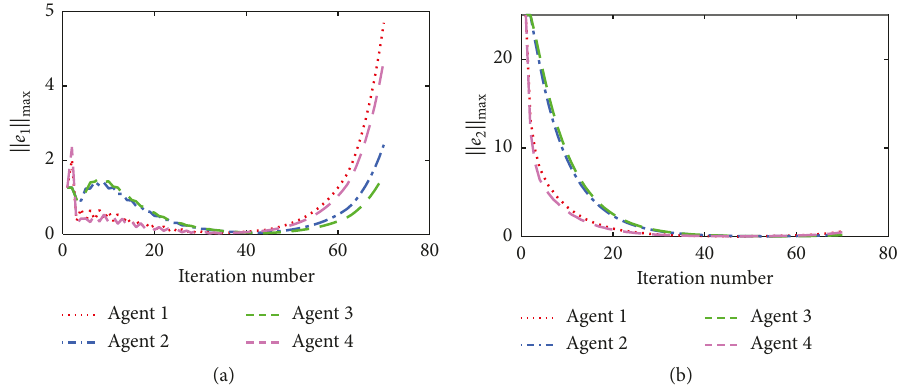
Figure 6: Results with open-loop PD -type IOILC. (a) Tracking error e